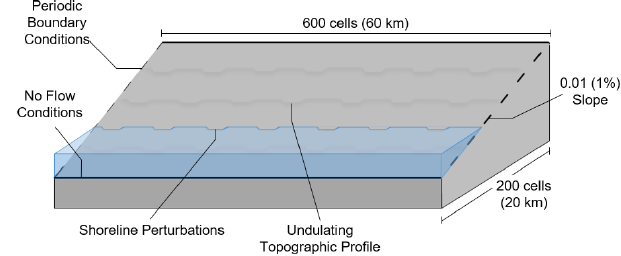
Figure 7. A schematic of CEM2D’s model set-up and the initial conditions used for simulations presented in this paper.